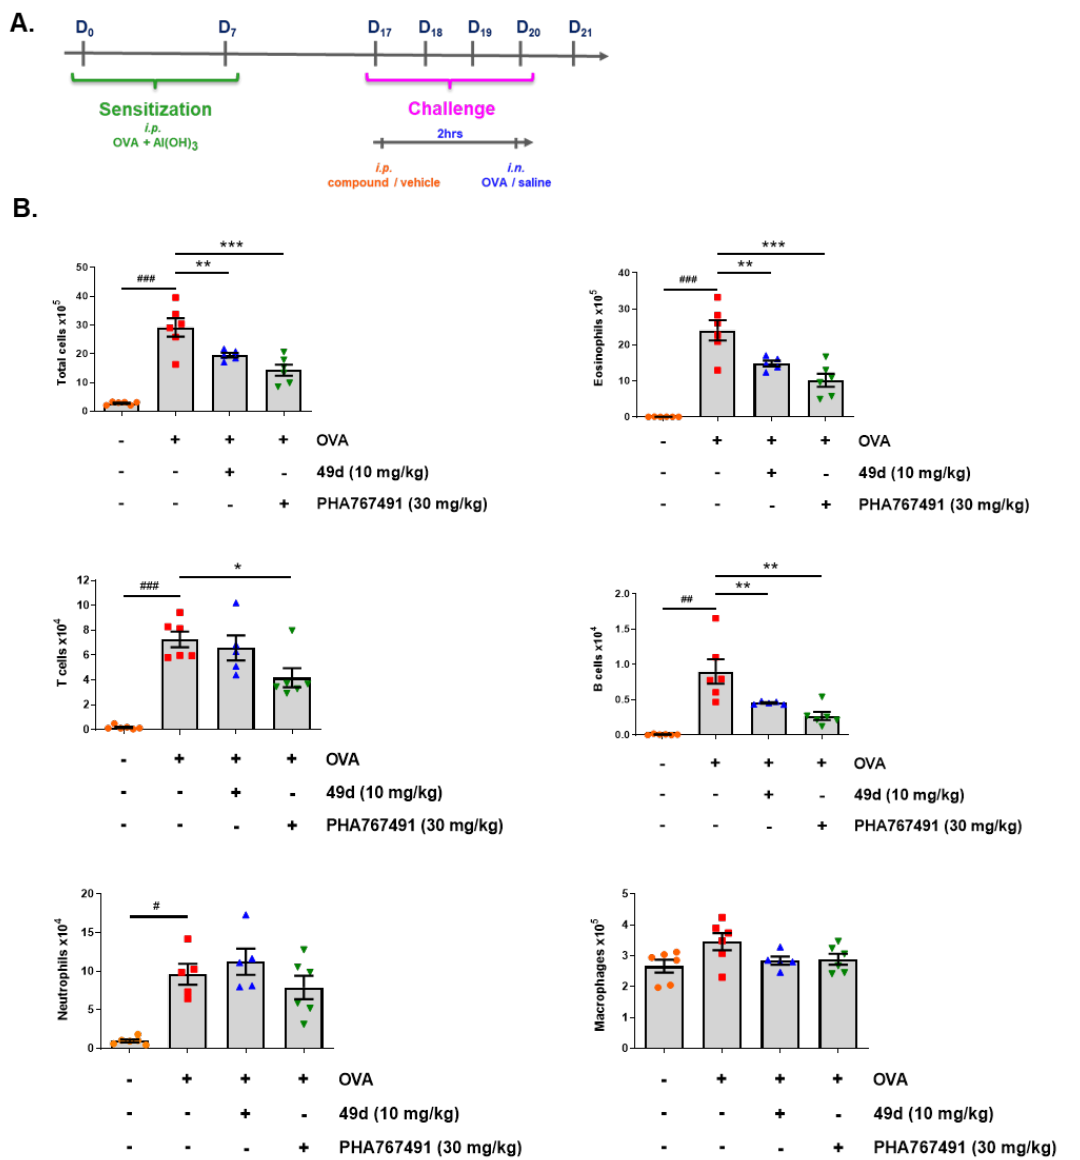
Figure 6. Effect of the new MSK1 inhibitor, 49d , on airway inflammatory cells recruitment in an OVA-induced asthma model in Balb/c mice, compared to reference compound PHA76491 . ( A ) Experimental design. Mice were sensitized by i.p. injections of OVA on days 0 and 7, and treated by i.p. with 49d (10 mg/kg), PHA767491 (30 mg/kg) or the solvent (DMSO 5%, NaCl 0.9%), 2 h before each OVA or saline challenge (25 µ l, i.n. ) on days 17, 18, 19 and 20. ( B ) Absolute numbers of total cells, eosinophils, B cells, T cells, neutrophils and macrophages in BAL are shown. Blocks are means and bars are SEM values ( n = 5–6). * p < 0.05, ** p < 0.01, *** p < 0.001 compared to OVA-solvent group. # p < 0.05, ## p < 0.01, ### p < 0.001 compared to control group .